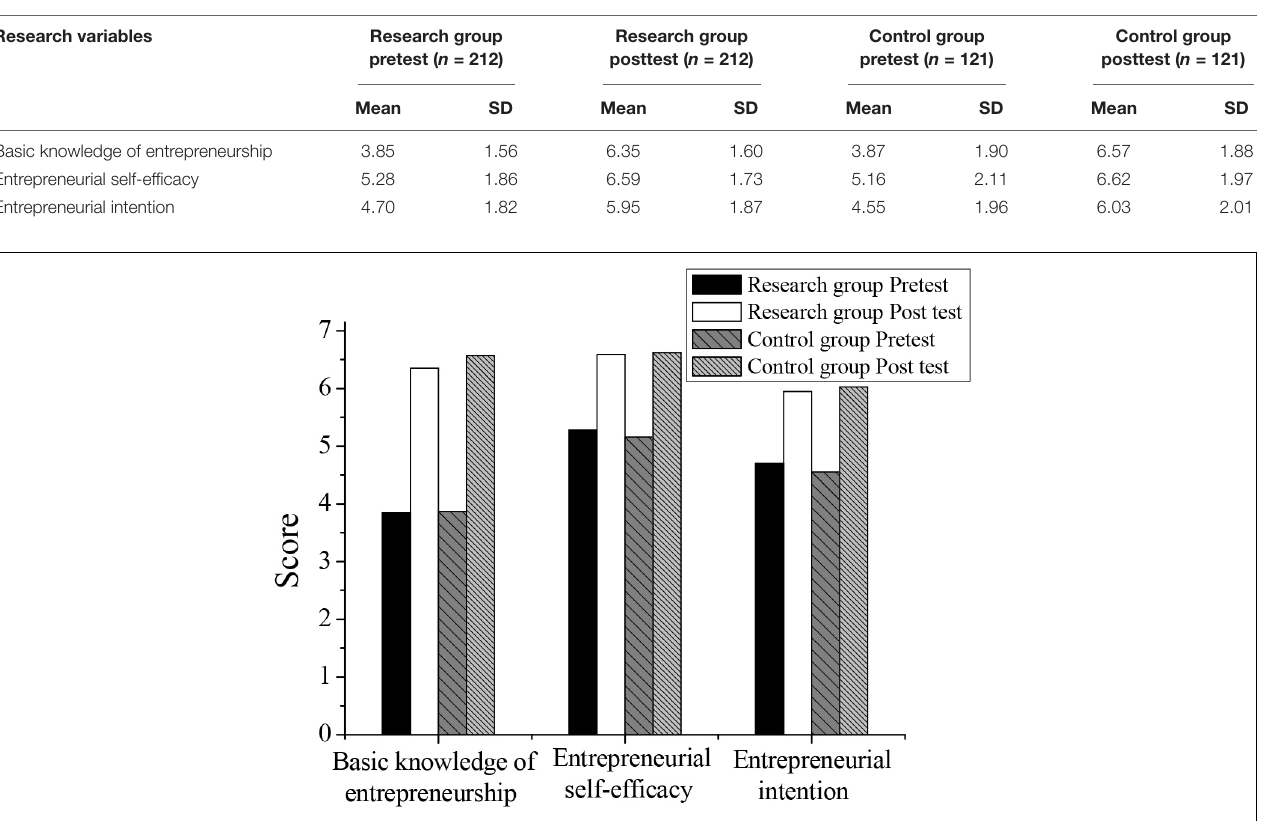
TABLE 2 | Descriptive statistics of students in the research and the control groups.